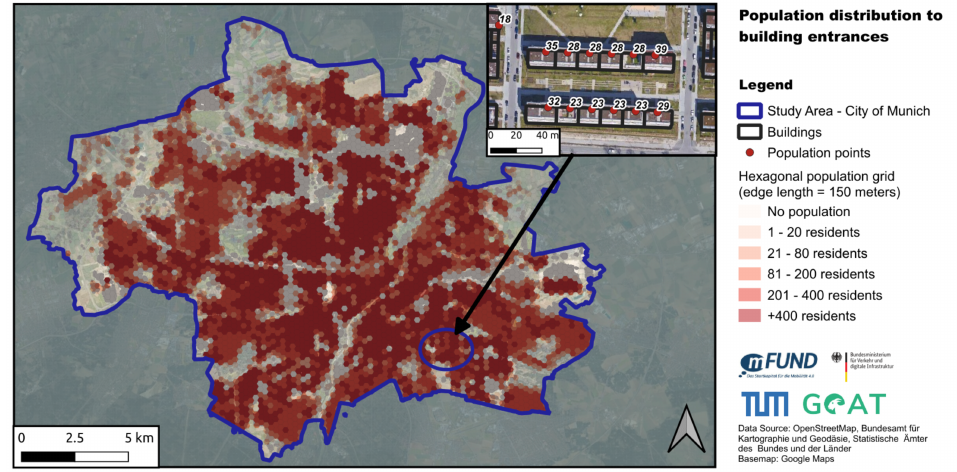
Figure 14. Population